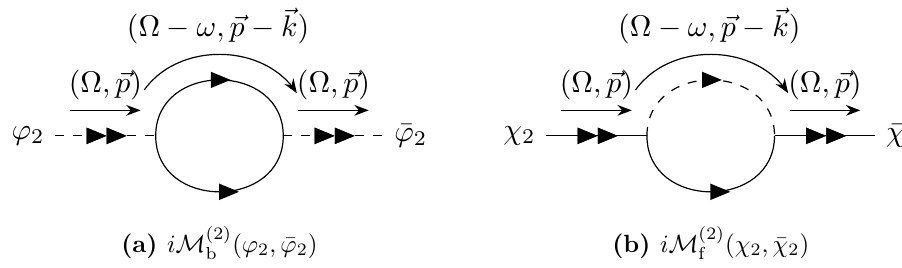
Figure 16. 1-loop correction to the scalar (a) and fermionic (b) self-energies in sector 2.